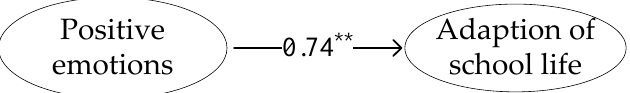
Figure 3. PLS results of the relationship between positive emotion and adaptation of school life. Note: ** p < 0.01.